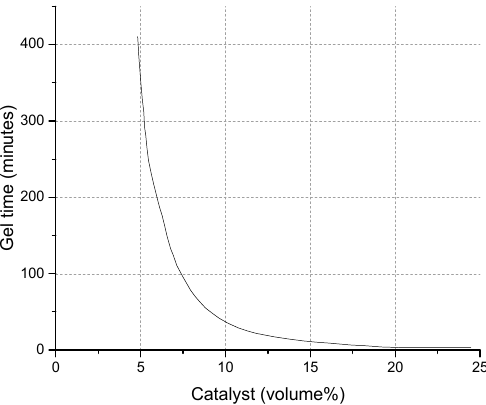
Figure 2. Adjustable gel time with varying catalyst dosage.